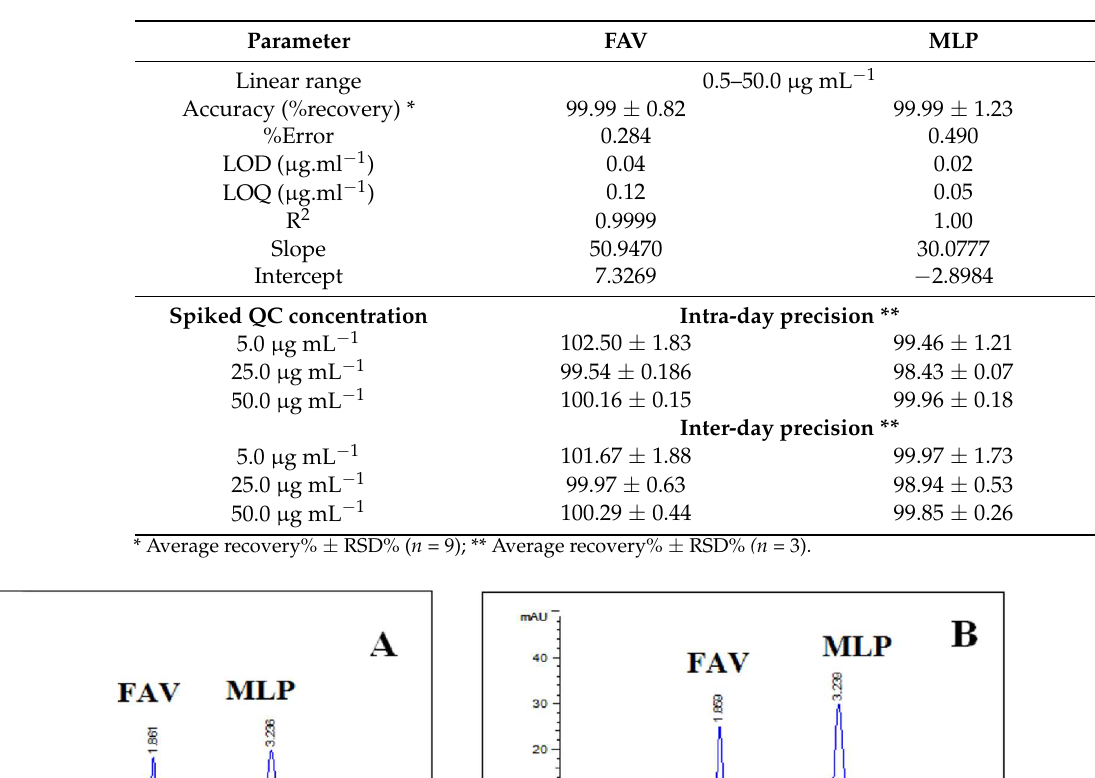
Table 5. System suitability and validation results for determination of FAV and MLP under the proposed LC method.